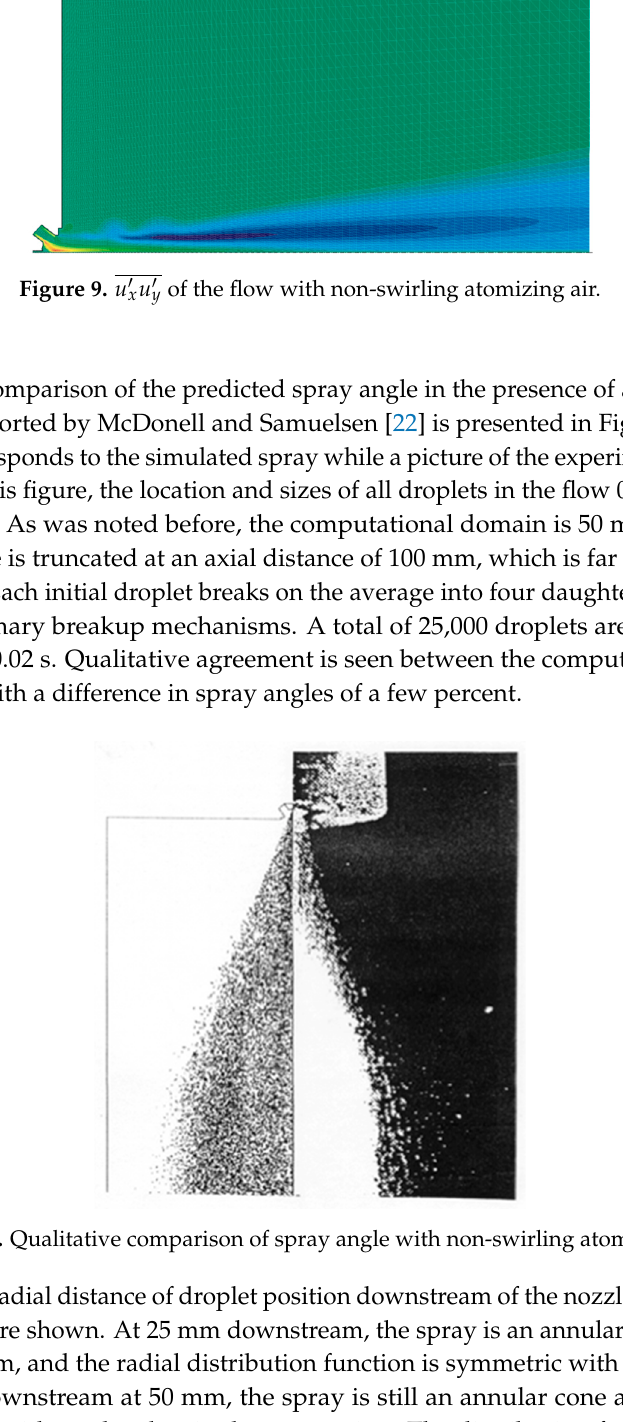
Figure 10. Qualitative comparison of spray angle with non-swirling atomizing air.